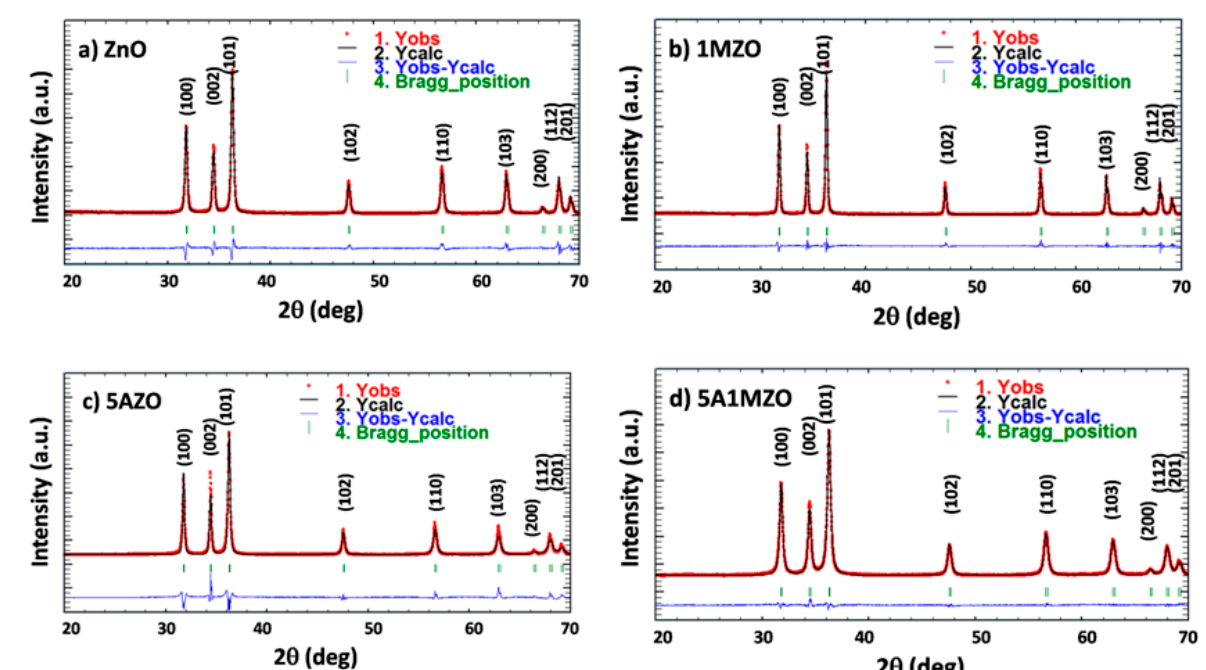
Figure 4. Fitted XRD patterns of ( a ) ZnO, ( b ) 1MZO, ( c ) 5AZO and ( d ) 5A1MZO nanoparticles.